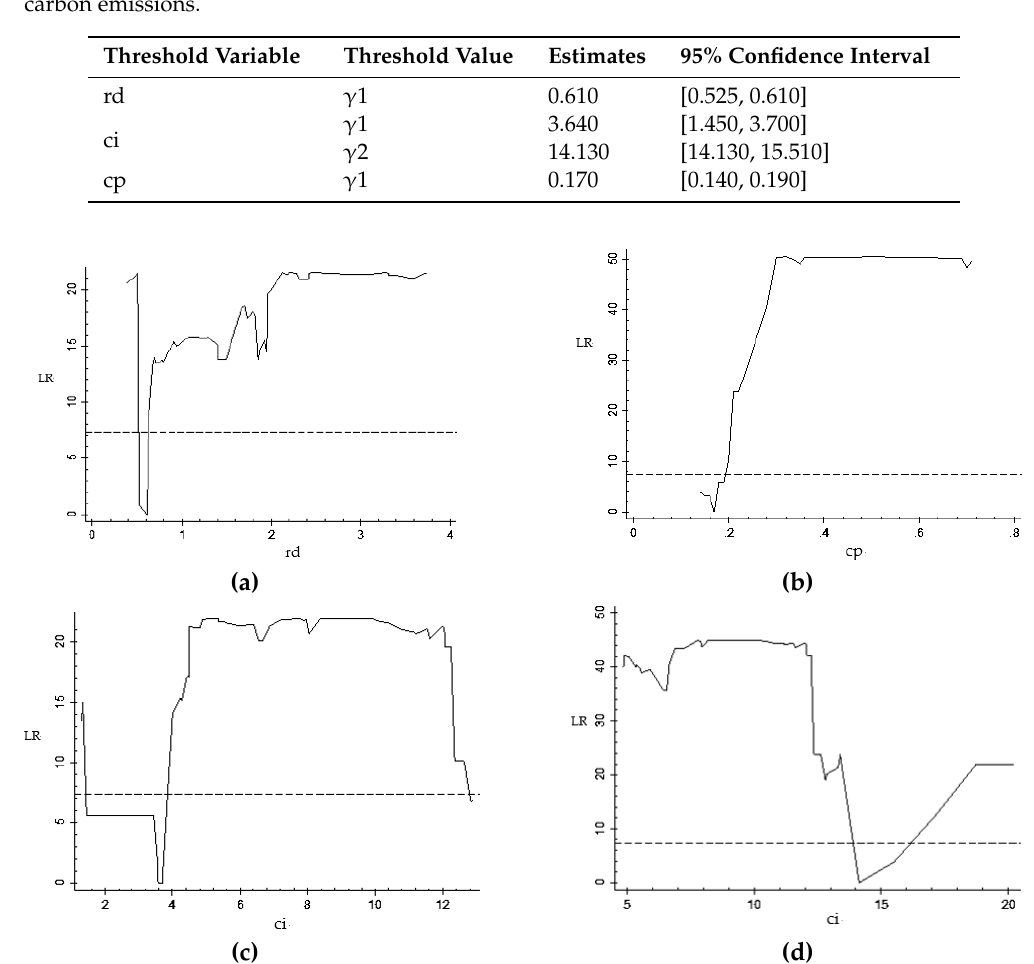
Figure 4. LR value and threshold parameter diagram of stock market value and carbon emissions. ( a ) rd-single-threshold model; ( b ) cp-single-threshold model; ( c ) ci-single-threshold model; ( d ) ci-double-threshold model. Table 10. Threshold estimation results and confidence intervals for stock market value and carbon